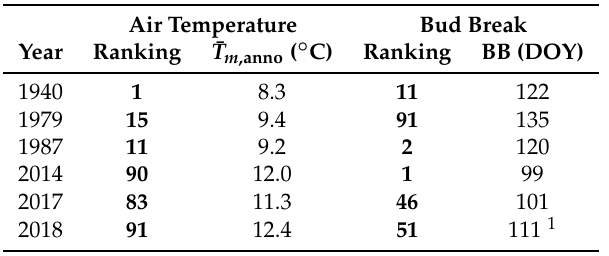
Table 1. Selected years with ranking position (1–91) for annual average of daily mean air temperature ( ¯ T m ,anno ) and estimated bud break date (BB) ( 1 - BB for 2018 is based on phenological observations instead of thermal time data; see Section 2.4.1).